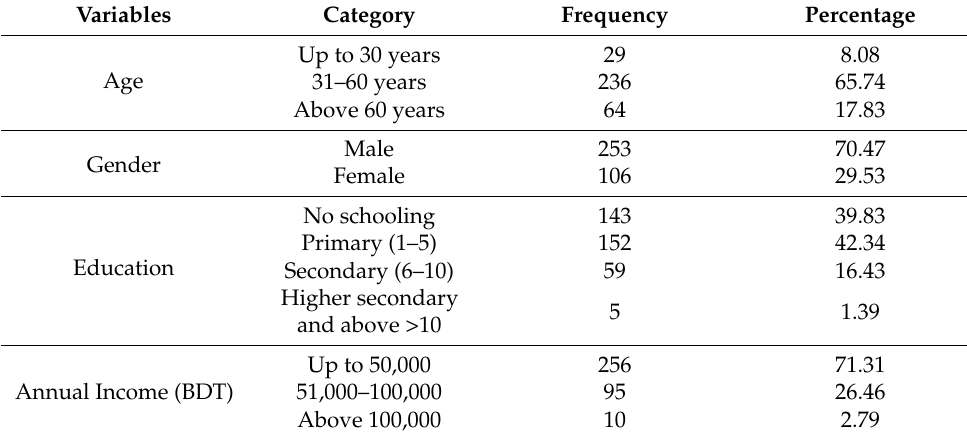
Table 2. Sociodemographic information of respondents ( n =